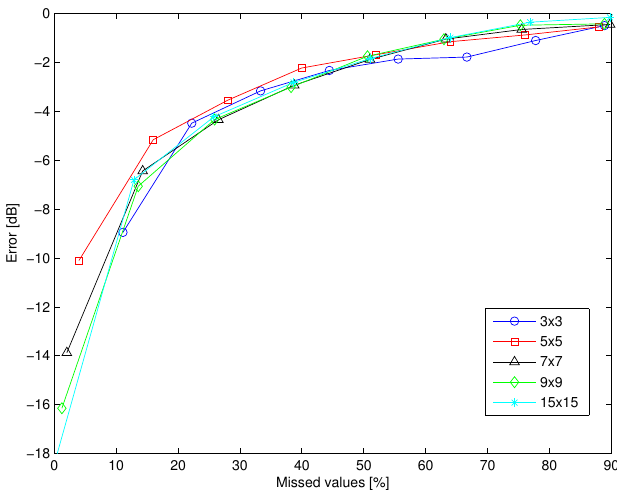
Figure 9. Error (dB) versus the percentage of missed data in case of the 3 × 3, 5 × 5, 7 × 7, 9 × 9 and 15 × 15 MIMO system; receiver in position 1; SNR equal to − 20 dB; the geometry of the problem is shown in Figure